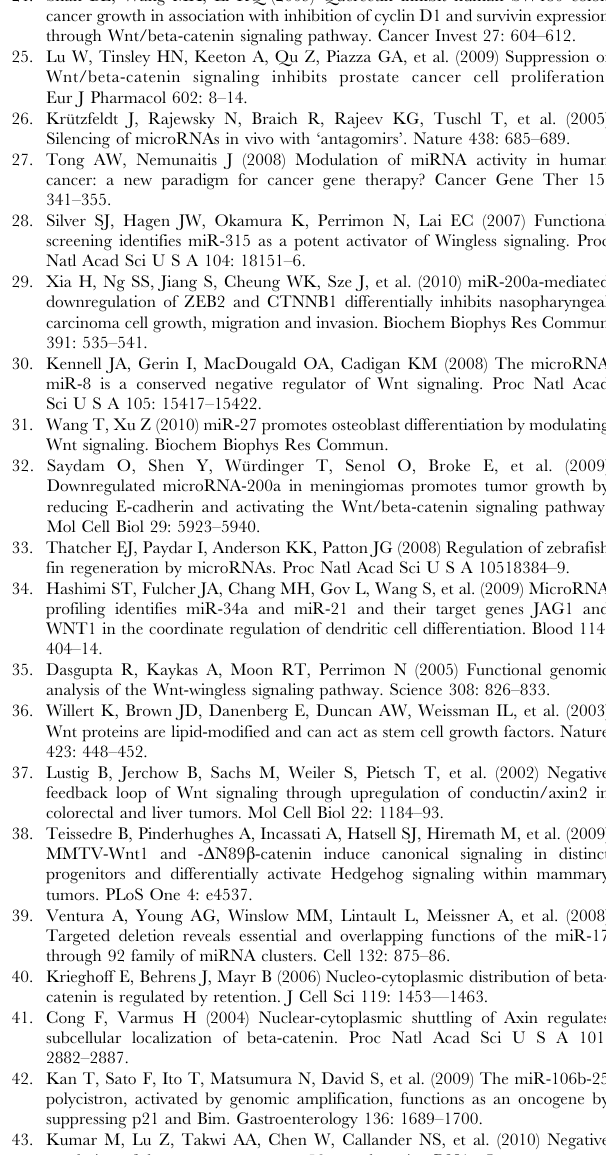
Figure S9 Primary screen data including Nexp (STF- 19x/CMV-renilla), p-values, standard deviation, aver- aged Nexp-values and list of estimated regulatory miRs. A graph illustrates validated miRs within the whole screen data (Nexp